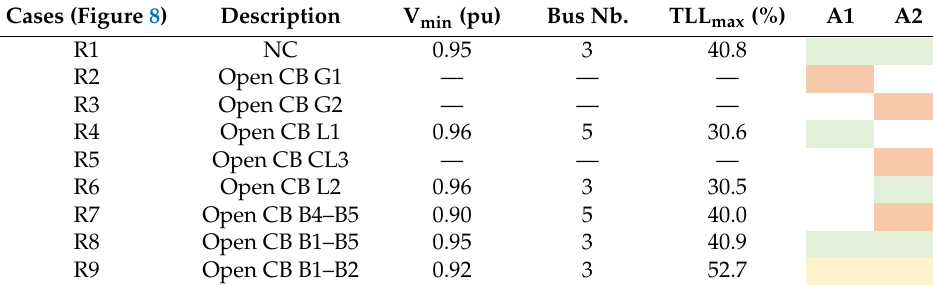
Yellow: Alert; Red: Malicious; Green: